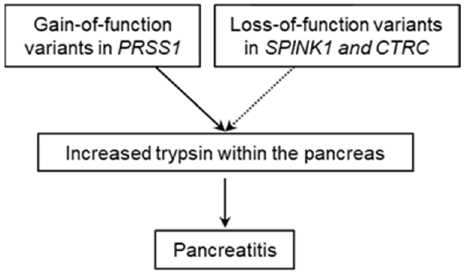
Figure 1. Schematic illustration of the trypsin-dependent pathway for chronic pancreatitis stemming from the identification of genetic variants in the PRSS1 , SPINK1, and CTRC genes.